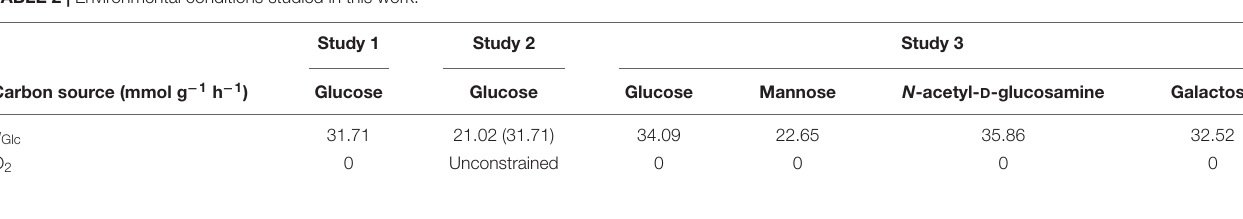
TABLE 2 | Environmental conditions studied in this